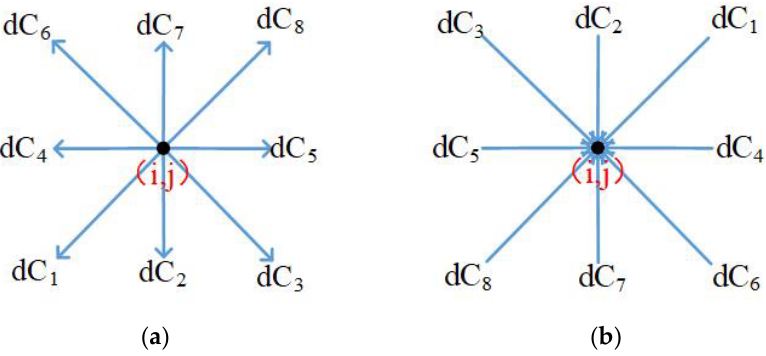
Figure 4. Avoiding data race (( a ) store ( b ) read->change).